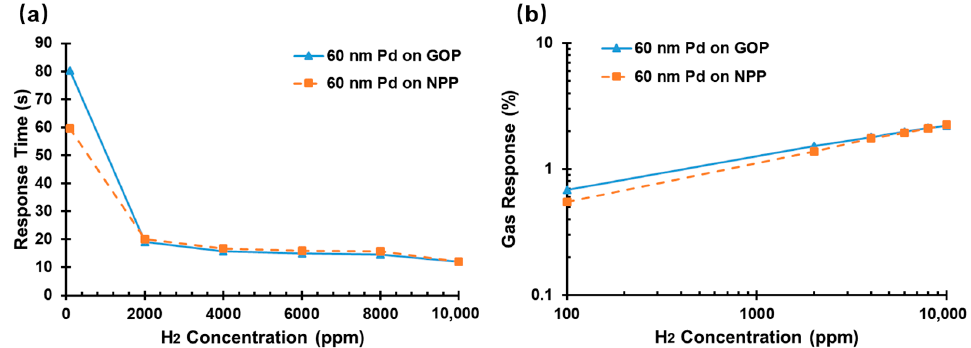
Figure 6. Performance of 60 nm Pd thin film H 2 sensors based on NPP (Reprinted with permission from Ref. [15]. 2022, Springer Nature) and GOP substrate at various H 2 concentrations at 25 °C. ( a ) Response time; ( b ) gas response.